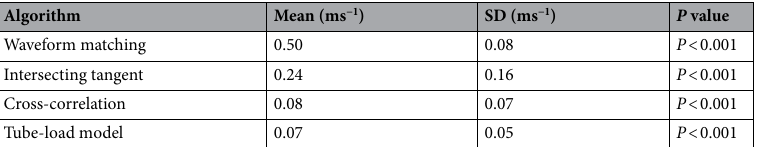
Table 6. The mean difference between cfPWV values of the noiseless signal and the signal with added noise over the four levels of added noise for each algorithm using the experimentally measured carotid and femoral pulse waveforms. P < 0.001 indicates significant difference between cfPWV values of the noiseless signal and the signal with added noise over the different SNRs for each algorithm using the multi-sample non-parametric Friedman